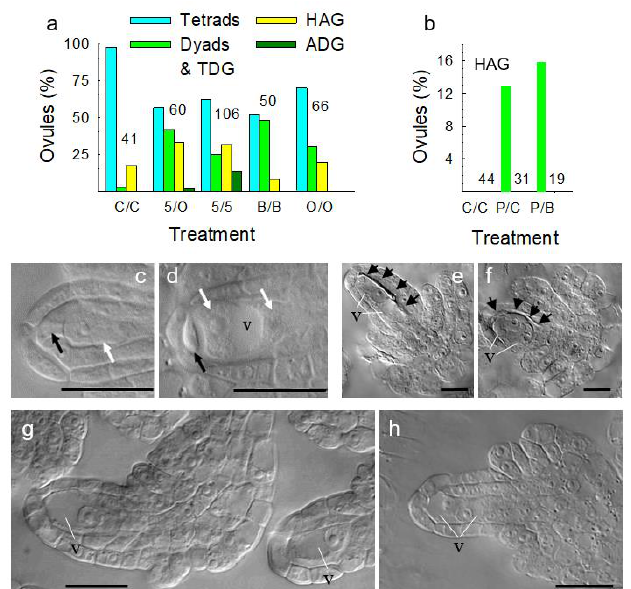
Figure 10. Taraxacum (TDG), Antennaria (ADG), and Hieracium (HAG) types of gametophyte formation induced in cultured Arabidopsis thaliana pistils: ( a ) percentages of ovules that produced sexual tetrads, sexual or TDG dyads or TDGs, HAGs and ADGs by treatment; ( b ) percentages of ovules that produced HAGs by treatment; ( c – d ) 1 and 2-nucleate TDGs induced by DTBA; ( e – f ) 1 and 2-nucleate HAGs induced by DTBA; ( g – h ) 1 and 2 nucleate ADGs induced by 5-azaC. 5, 5-azaC; B, brassinolide (BR); C, control; O, other (B or DTBA); P, 7 min H 2 O 2 pretreatment. Numbers of informative ovules analyzed appear next to treatment bars in ( a ) and ( b ) (values are sums of four and two replicates, respectively). Pooled chi-squares were significant ( p < 0.001). v, vacuole; cytology bars, 20 µ